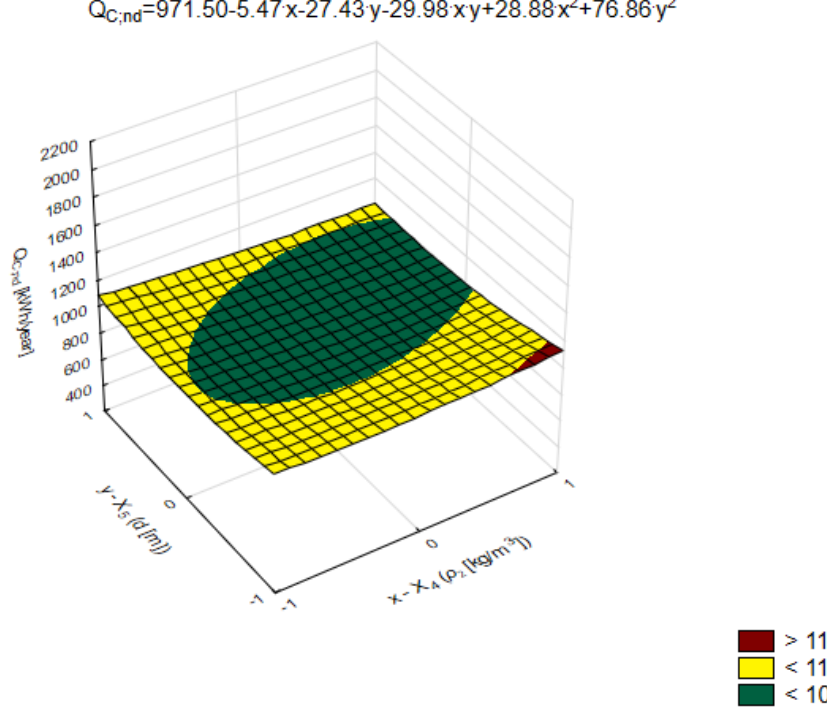
Figure 11 Figure 11. Dependence of Q Cnd on two most important factors from the second group of parameters, i.e., structural, concerning the solutions of building elements: X 4 —density of material of internal wall ρ 2 and X 5 —thickness of internal walls d .